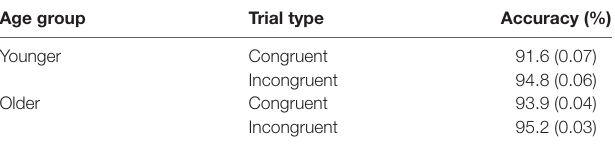
TABLE 1 | Proportion of correct responses and standard deviations (in brackets) during the encoding